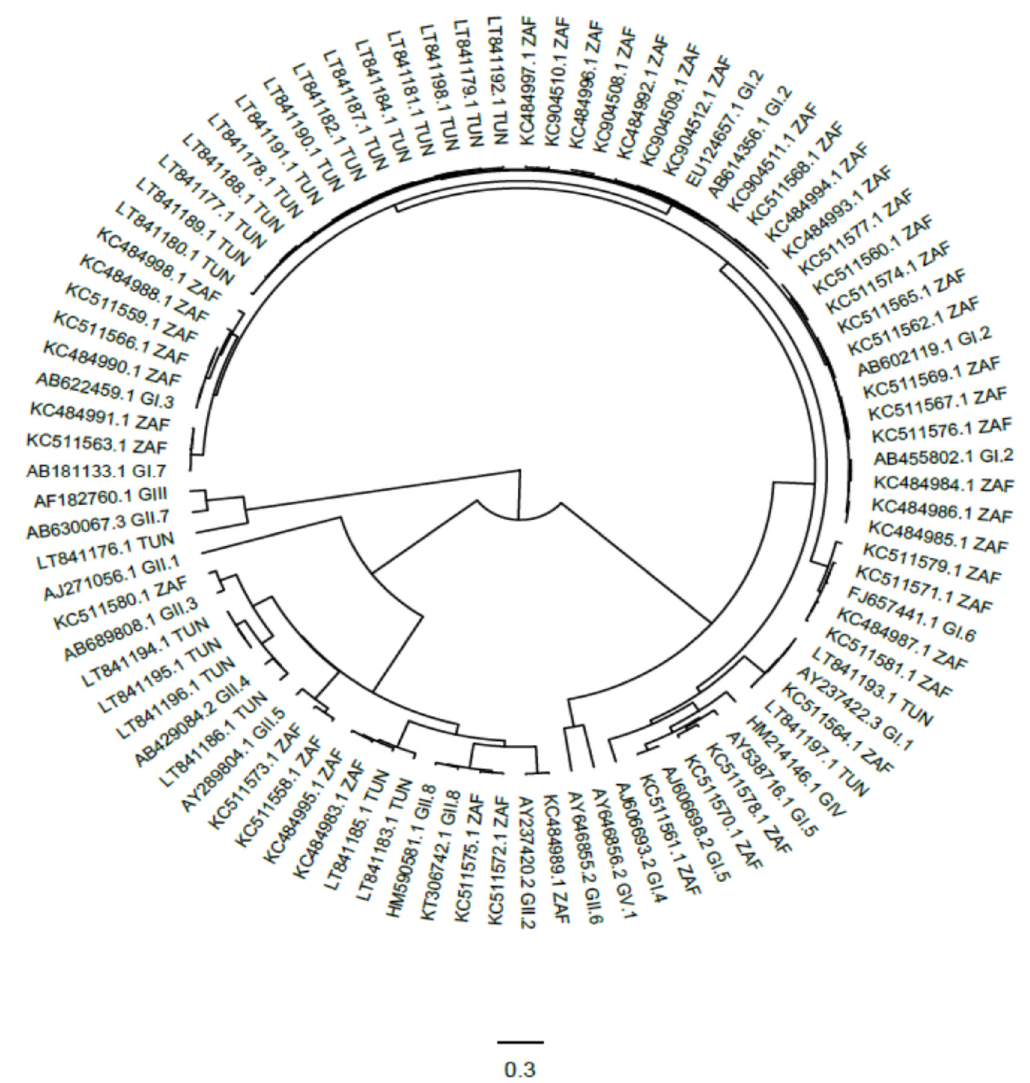
Figure 4. A phylogenetic tree of environmental sapovirus, 260 bp of partial VP1 region, sequences. Reference sequences are annotated with accession number and genotype while sequences from reviewed studies have accession number and country code. The evolutionary history was inferred by using the (BEAST v 1.10.4) Bayesian method, GTR model.